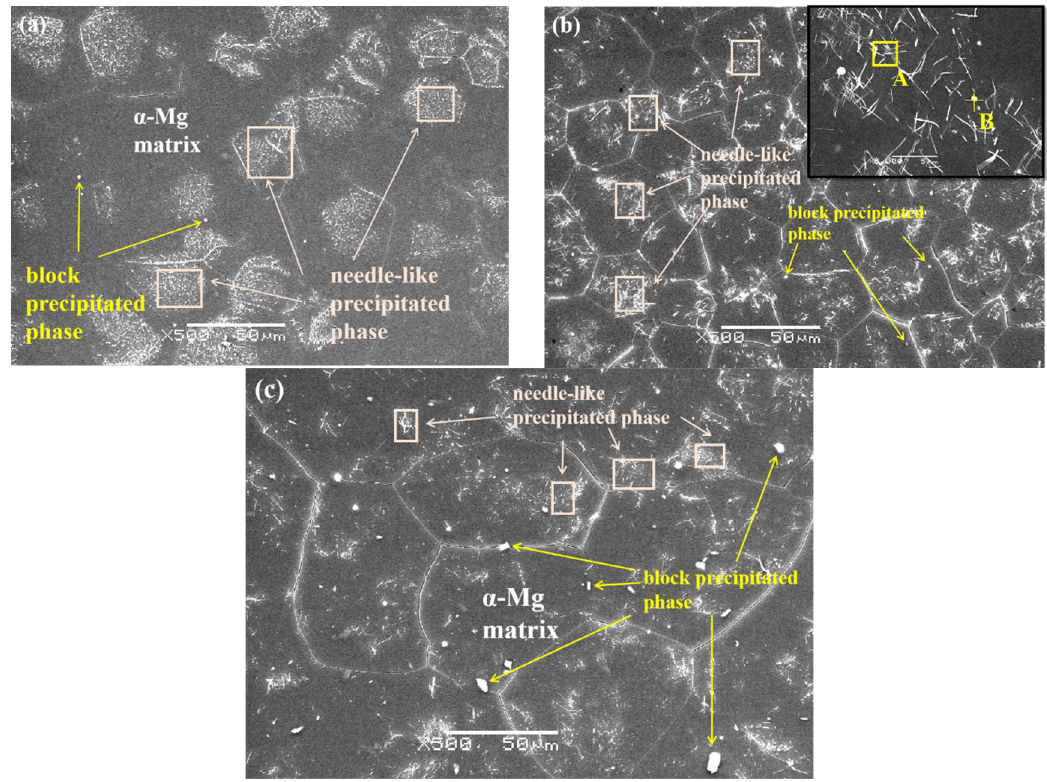
Figure 3. SEM images of the T6-treated alloys. ( a ) GZ31K, ( b ) GZ61K, ( c )